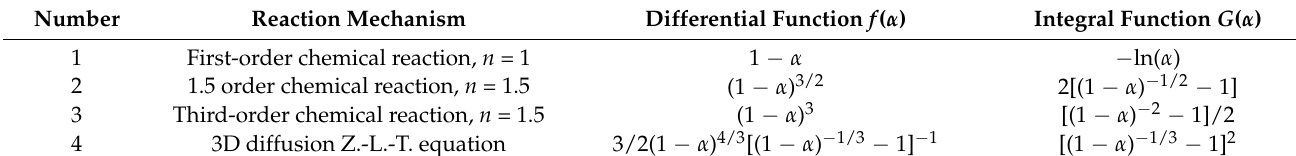
Table 2. Common mechanism functions.